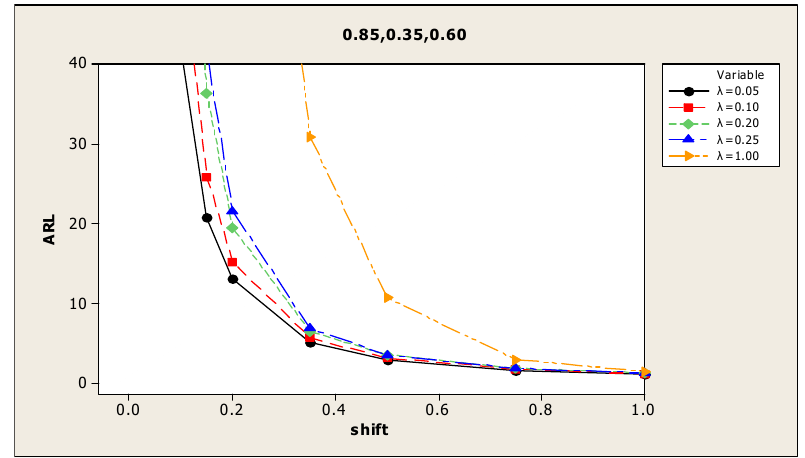
Figure 11. ARL curves when ρ yu = 0.85, ρ yv = 0.35, ρ uv = 0.60 at above values of λ .